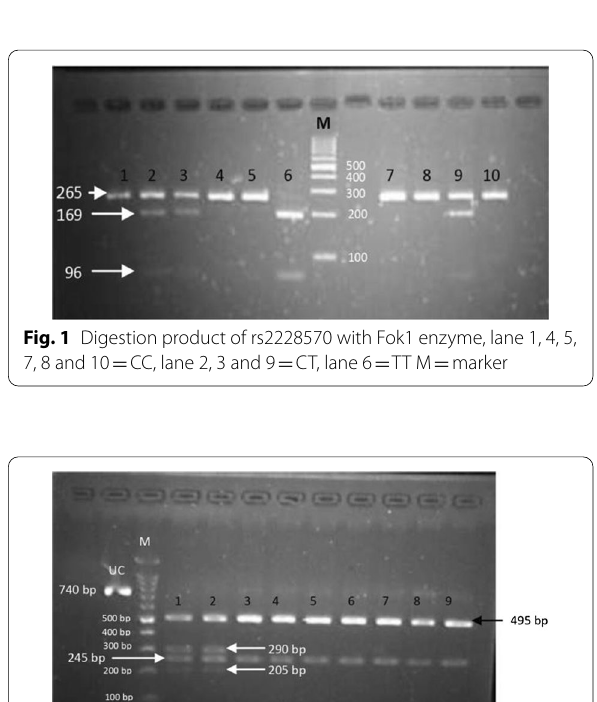
Fig. 2 Digestion products of rs731236 with Taq1 enzyme, lane 1 and